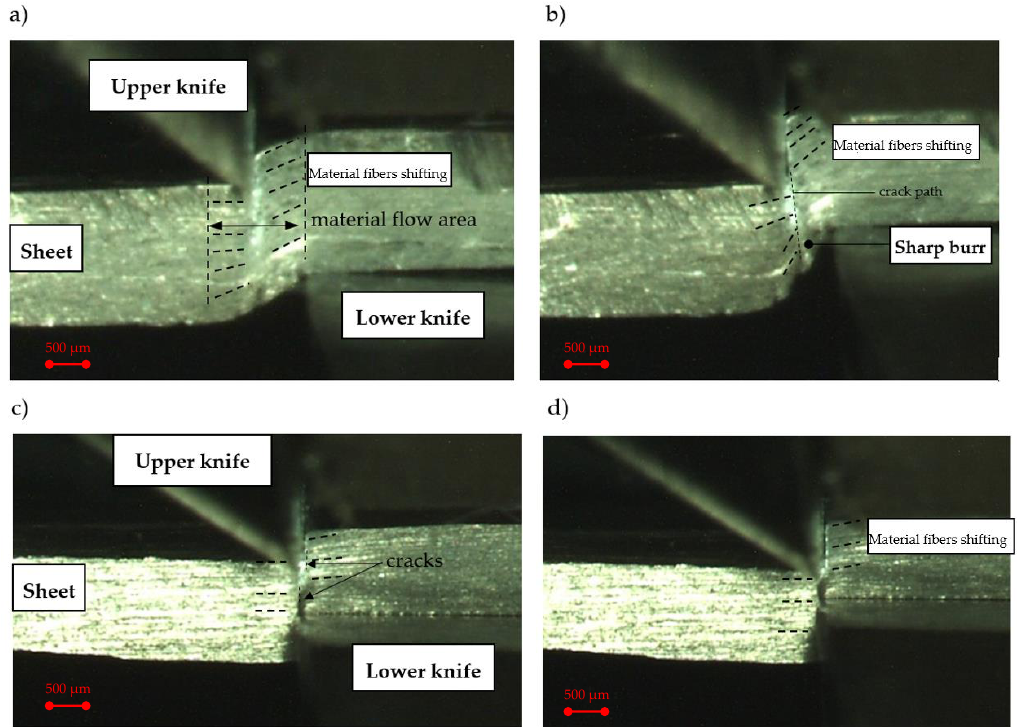
Figure 4. Shear-slitting process registered at the sheet cross section (α = 40°): ( a ) material plastic flow phase (h c = 0.15 mm), ( b ) cracking phase (h c = 0.15 mm), ( c ) plastic flow with cracking phase (h c = 0.03 mm), ( d ) final separation (h c = 0.03 mm).